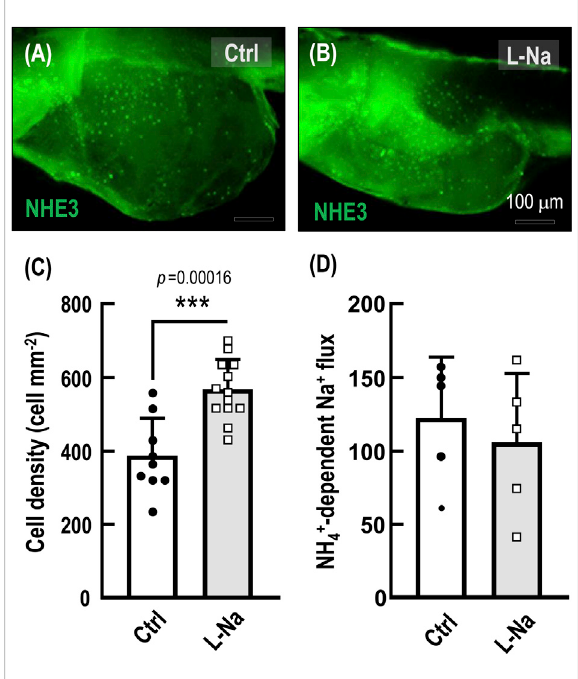
FIGURE 5 Effects of low-Na + acclimation on medaka ionocyte cell density and NH 4 + -dependent Na + uptake. Medaka embryos were acclimated to low-Na + (0.01 mM, L-Na) or control freshwater (1.02 mM, Ctrl) for 7 days and then were subjected to the measurement of number of NHE3-expressing ionocytes and NH 4 + -dependent Na + uptake at the ionocytes. (A – C) , Acclimation to L-Na resulted in increased cell number of Na + /H + exchanger 3 (NHE3)-labeled ionocytes in medaka compared with that of the Ctrl group. (D) , The NH 4 + -dependent Na + uptake (derived from Figure 3B) at the ionocytes did not change between the L-Na and Ctrl groups. Data are presented as mean ± SE. Asterisks indicate signi fi cant difference of p < 0.001 (***) (Student ’ s t -test).